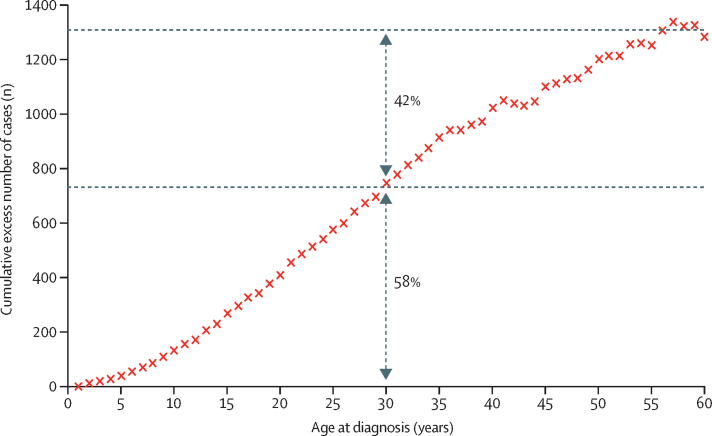
Cumulative excess of genetically defined cases of type 1 diabetes occurring throughout the first six decades of life58% (749/1286) of type 1 diabetes cases were diagnosed when individuals were aged 30 years or younger; 42% (537/1286) were diagnosed when individuals were aged 31–60 years.